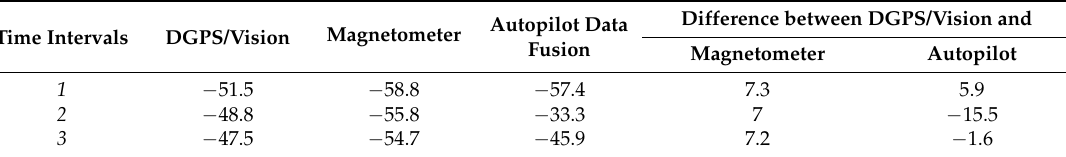
Figure 18. Heading angle as a function of time ( Top ), differences of DGPS/Vision with respect to autopilot and magnetometers ( Bottom ) during the third flight segment (Test 1). Table 3. Heading comparison (mean values in degrees).